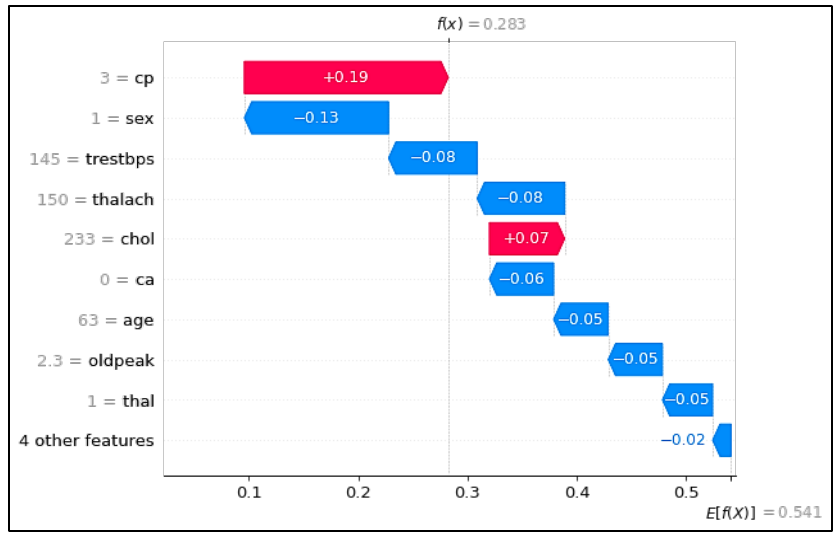
Figure 6. SHAP value for the ‘age’ factor.